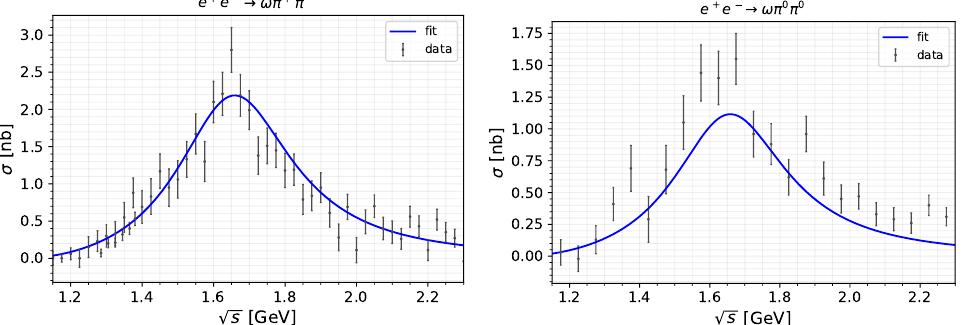
Figure 19 . Cross-section for the charged ωπ + π − (left panel) and neutral ωπ 0 π 0 (right panel) hadronic final states. The blue curve shows the best fit solution to the cross-section, obtained considering the fit values of table 4. The black points and error bars represent data from [35, 36, 67].